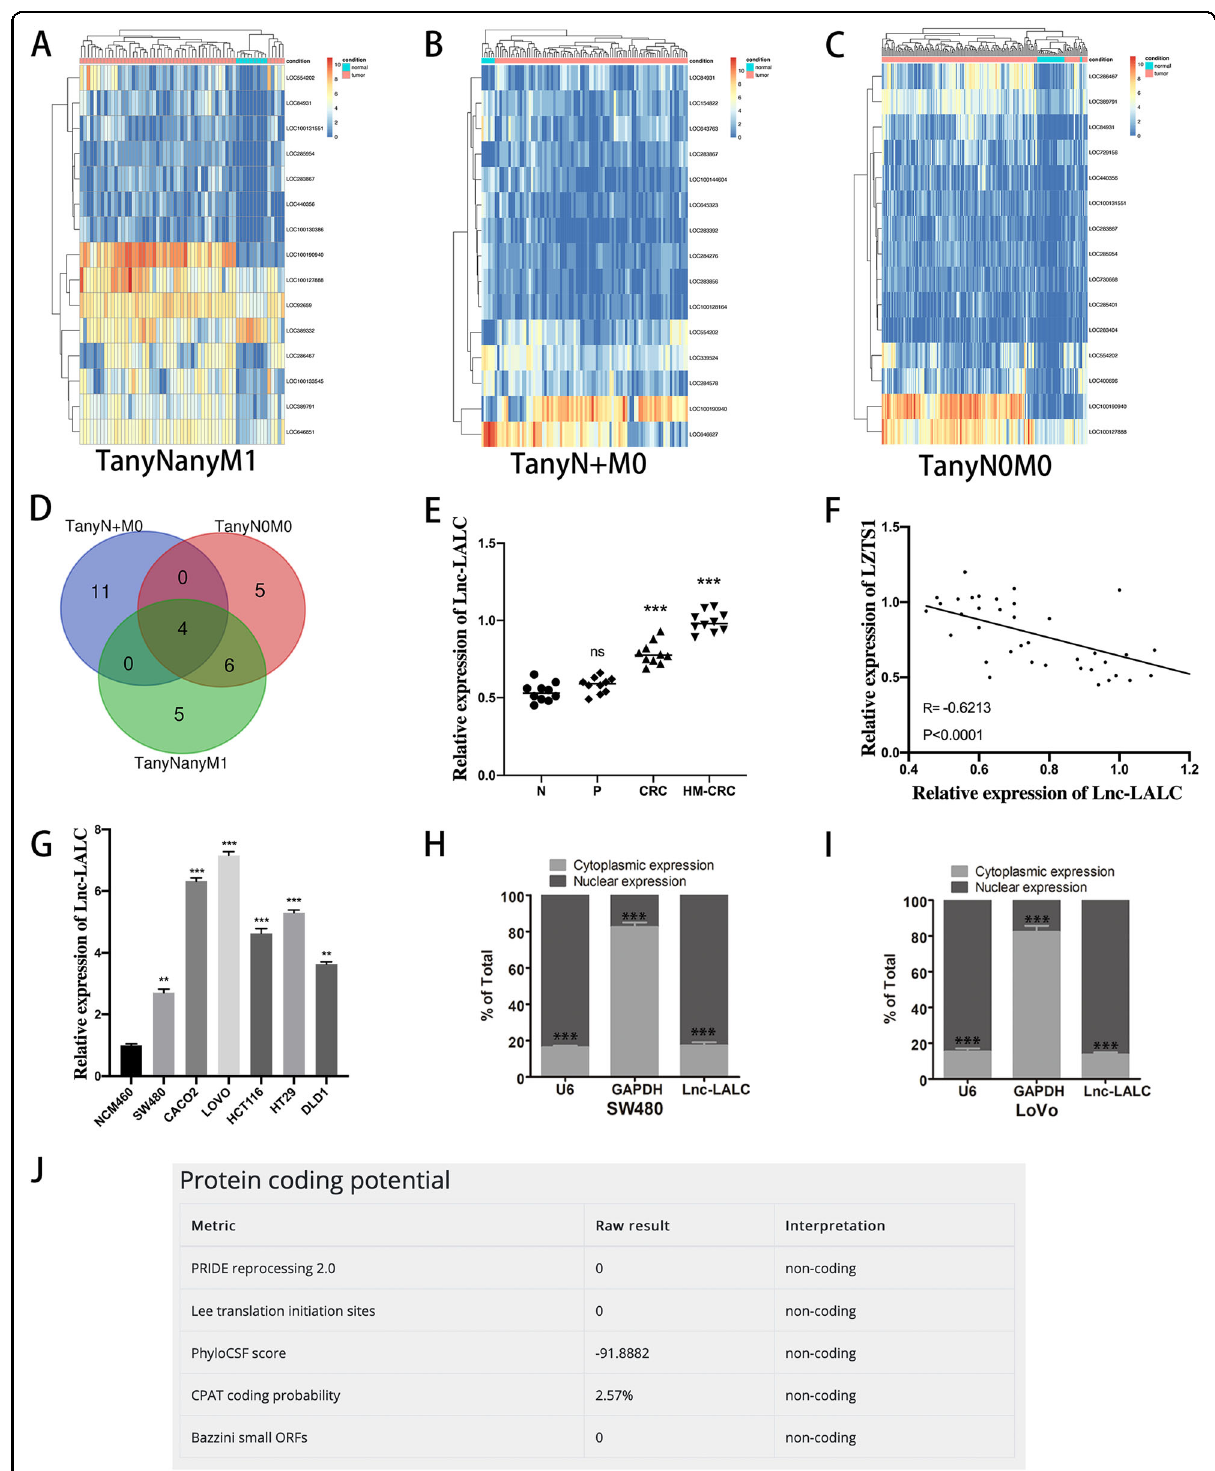
Fig. 2 (See legend on next